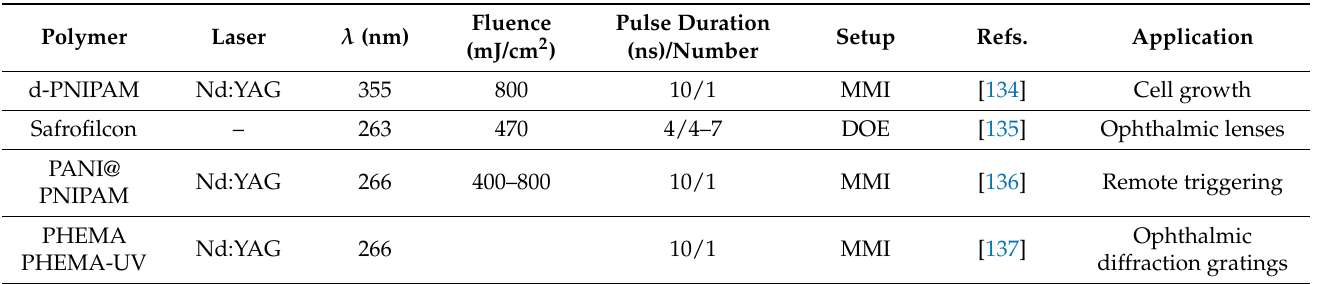
Table 5. Summary of DLIP parameters used with synthetic hydrogels.